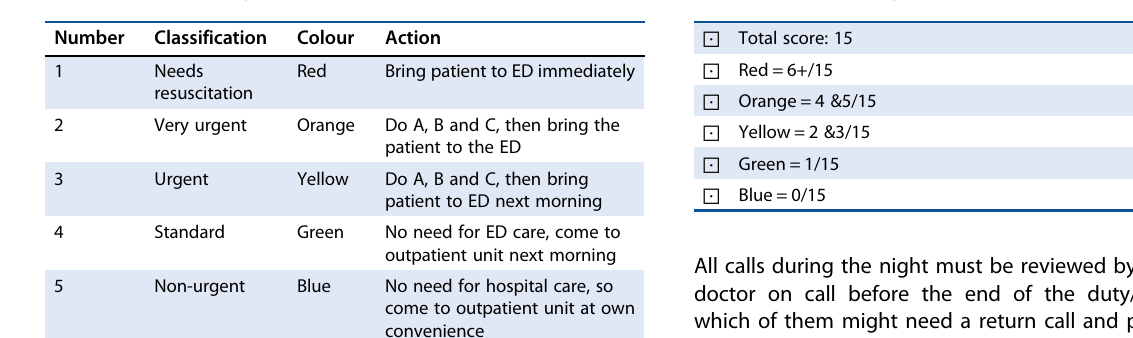
Table 1: Telephone triage